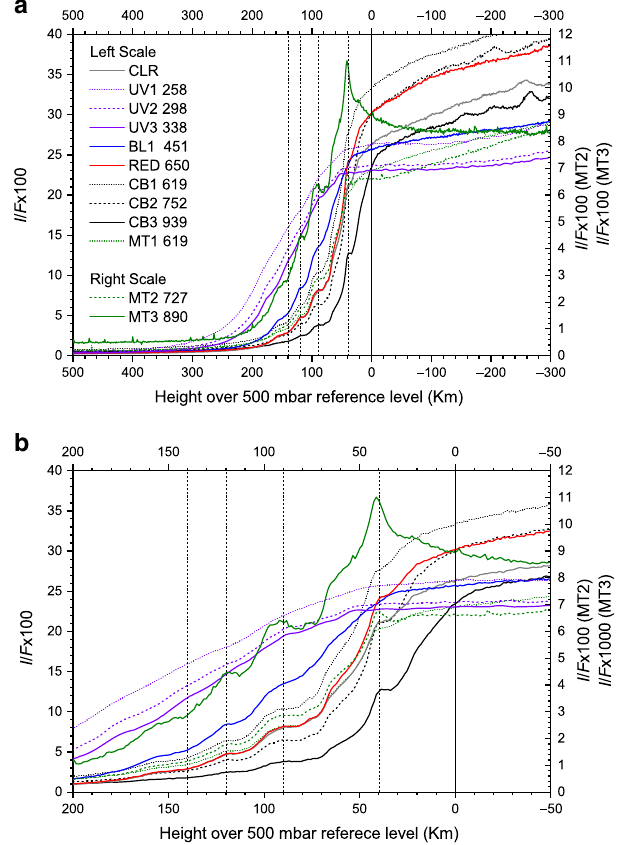
Fig. 2 Re fl ectivity scans of the haze layers at different wavelengths. a Re fl ectivity pro fi les ( I / F ) extending from the limb to the upper atmosphere (sky background). b Zoom and detail of the re fl ectivity pro fi les close to the limb. Error bars in ( I / F ) for all fi lters are similar to those shown in Fig. 1 (not shown here for clarity). Note the change in the scale of the re fl ectivity according to the fi lters used (left and right y axis). Filters are identi fi ed by their Cassini ISS code (Supplementary Table 1) and their effective wavelength is given in nm. The vertical lines indicate the altitudes where the I / F values were used for the radiative transfer